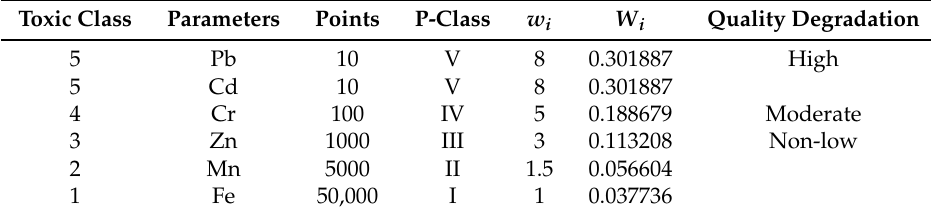
Table 1. The classification of water quality degradation level according to PoS index. Toxic